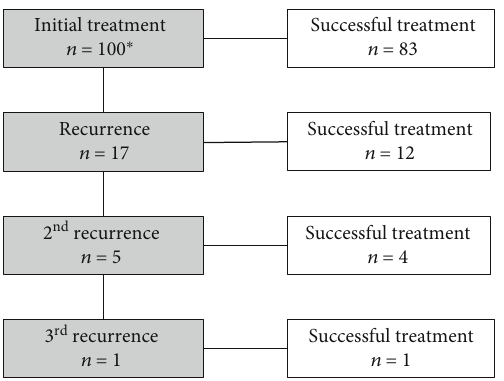
Figure 2: Flow chart of patients with recurrence. Recurrence: recurring symptoms after a temporary improvement. ∗ 103 sessions in 100 patients due to three two-stage